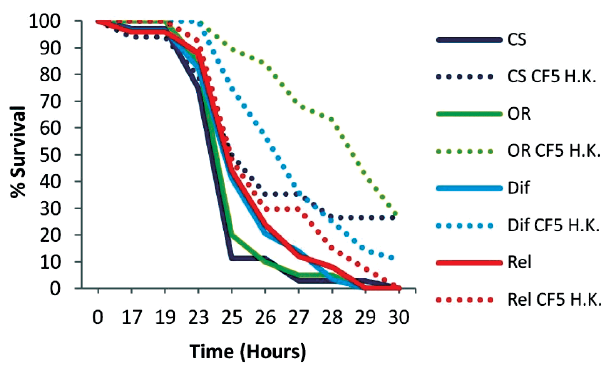
Figure 3. Survival kinetics of wt and humoral response deficient flies 2 days post priming with heat-killed Pseudomonas aeruginosa CF5. Wild type Oregon R (OR) and mutant flies of the Imd (Rel) and Toll (Dif) pathways were primed with heat-killed (H.K.) CF5 cells (doted lines) 2 days prior to PA14 challenge. Primed OR flies showed extended survival times and 30% survivors (P<0.0001). Rel mutant control and primed flies died at similar rates indicating a protective role of the rel gene (Rel P=0.2199). Dif mutant flies exhibited a low but significant protective effect (P=0.001). n=19–29 flies per condition.